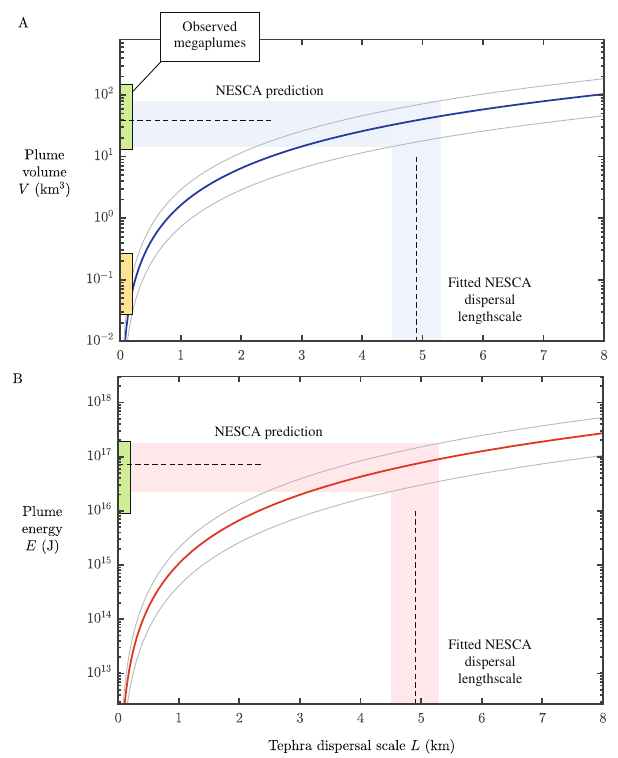
Fig. 4 The inversion results for plume umbrella volume and total energy and comparison with observed event plumes. ( A ) The total volume and ( B ) total energy predicted by our model as functions of the observed tephra dispersal lengthscale ( L ), de fi ned as the decay scale of the Gaussian model of Eq. (1) (and equal to the distance from the center encompassing ~93% of the mass of tephra dispersed by the umbrella of the particle group under consideration). The value used for the Brunt-Väisälä frequency is N = 10 − 3 s − 1 and the eruptive timescale used to convert our energy fl ux into a total energy is taken here as the representative value τ = 15 h (as derived in our results section, where a range of 10 – 20 h is inferred based on the lava volume and morphology). The thick curves are evaluated for a settling speed of w s = 3 cm s − 1 , for the particle range 250 – 500 μ m used in the inversion. The other curves (gray) represent the minimal and maximal inferences that would apply for settling speeds of w s = 2 cm s − 1 and duration τ = 10 h, and w s = 4 cm s − 1 and duration τ = 20 h, covering ranges of uncertainty in these parameters. Bands represent the inferred values based on the fi tted dispersal length scale L = 4.9 ± 0.4 km determined by our fi tting to the observed data for the Northern Escanaba (NESCA) eruption (Fig. 2). The range of volumes and heat energies of observed megaplumes (volume ≥ 10 km 3 ) 5 are indicated by the green bars along the vertical axes, showing consistency with both of our predictions. This indicates that a megaplume was produced during the NESCA eruption. The volume range of the considerably smaller group of event plumes observed at the Lau Basin 6 are indicated by the orange bar in ( A ), potentially forming a distinct category of event